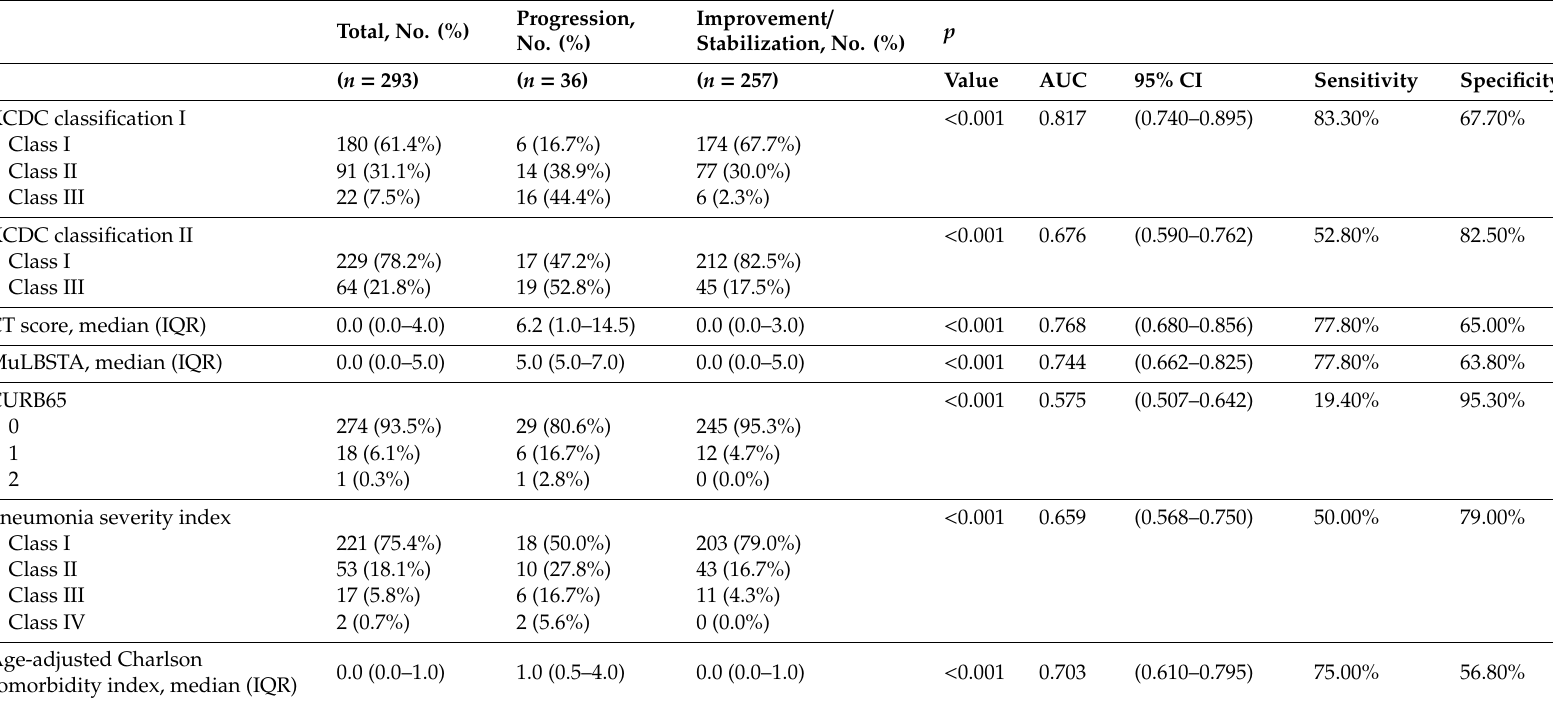
Table 3. Predictive models for disease severity and progression of patients with COVID-19